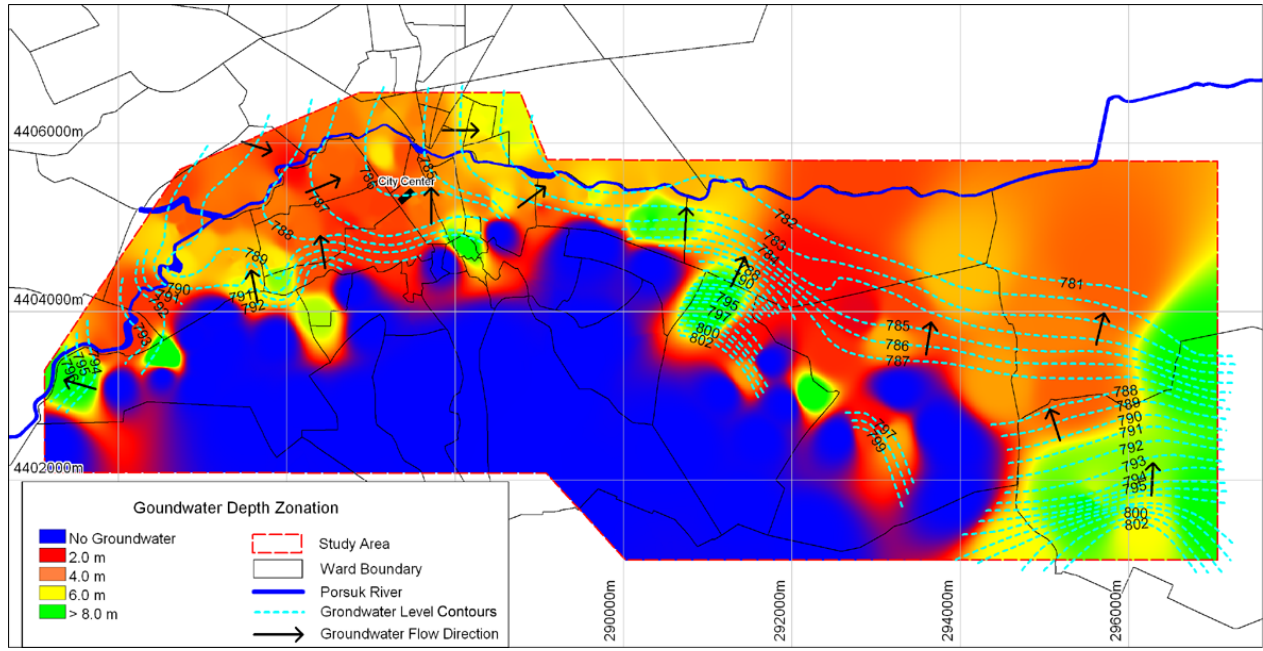
Fig. 3. Groundwater level contour and depth zonation map of the study area.